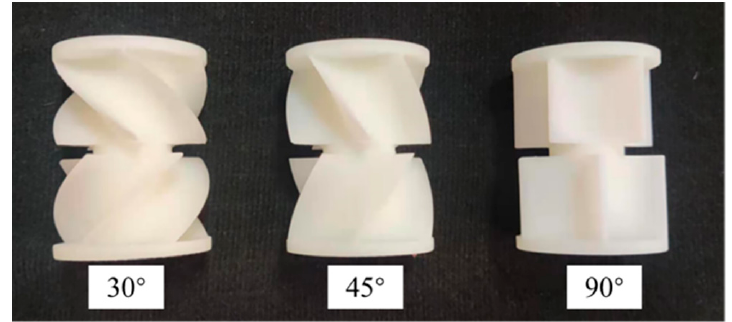
Figure 7. Three-dimensional printing feeding wheels.